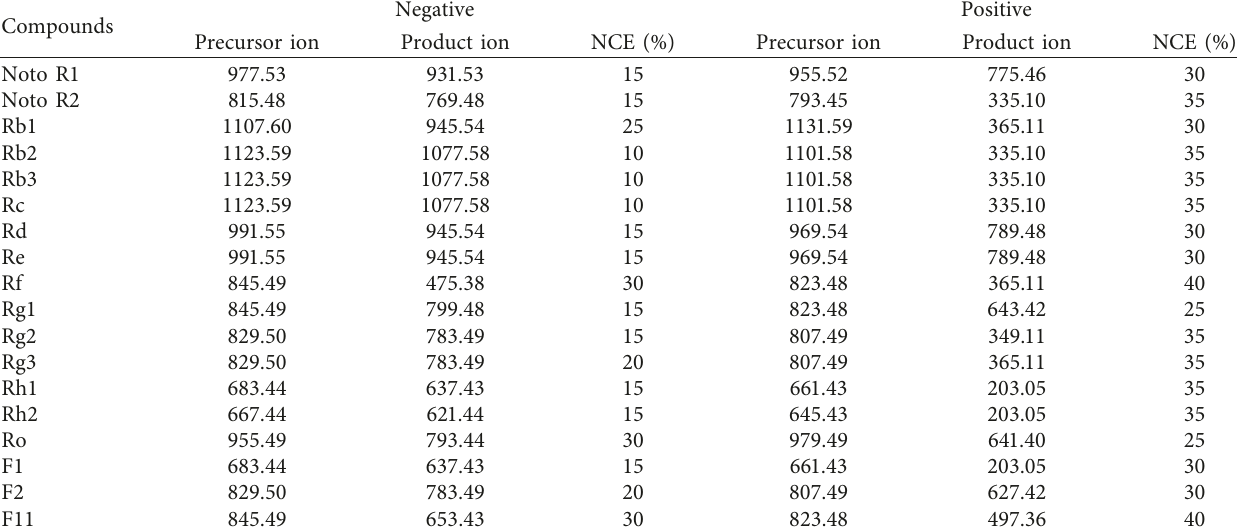
Table 3: Results of optimization for product ions and normalized collision